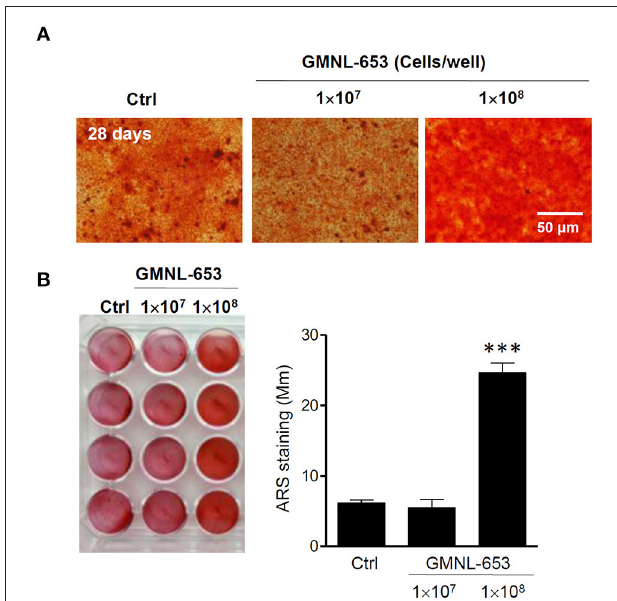
FIGURE 2 | Heat-killed L. paracasei (GMNL-653) increased calcium mineralization in human osteosarcoma MG63 cells mineralizing in culture. (A) Human osteosarcoma MG63 cells are incubated with heat-killed GMNL-653 in osteoinduction medium for 28 days. Following fixation, the cells are stained with Alizarin Red S to measure calcium deposits. (B) Quantification of Alizarin Red S stain by the absorbance (405 nm) of the red extracts according to the manufacturer’s instructions. *** P < 0.001 compared with the control group.